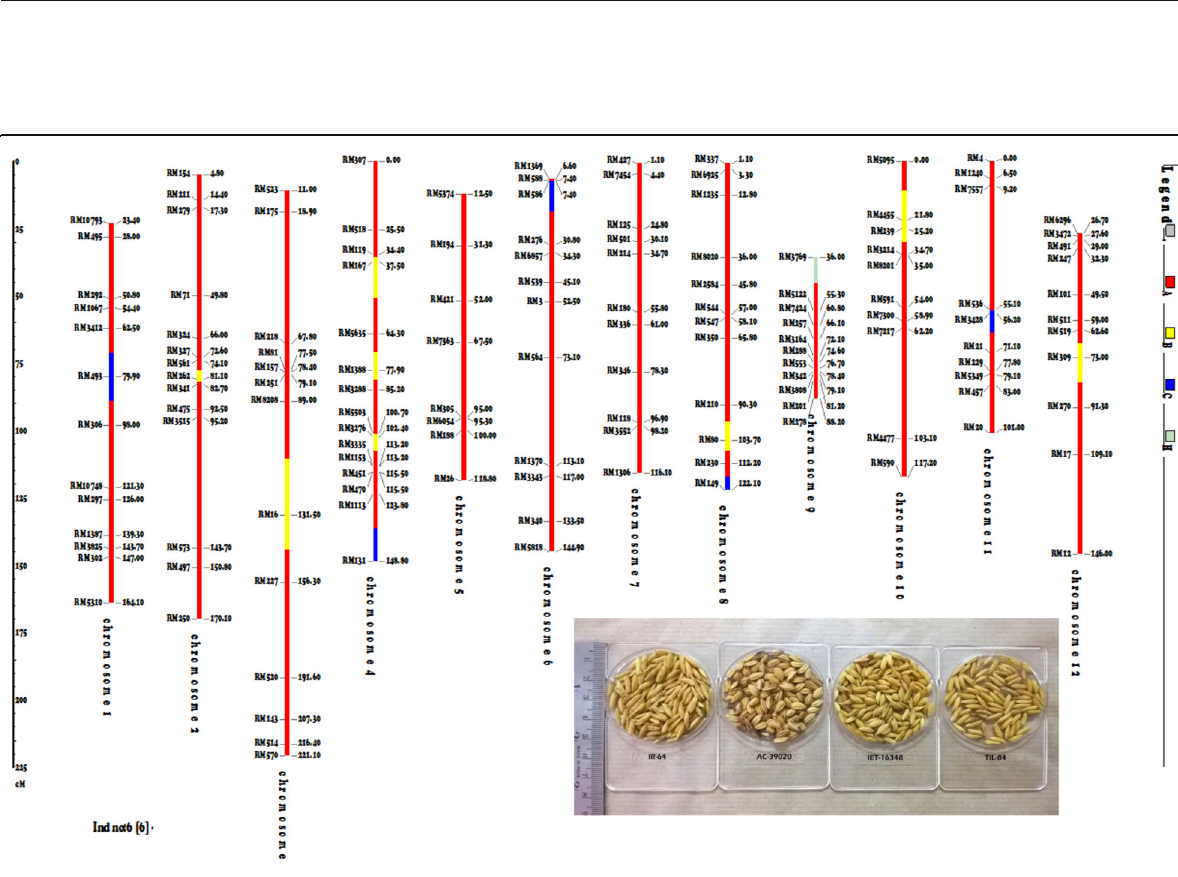
Fig. 4 Graphical genotyping plot and the grain characters (inset) for a selected TIL namely 32 – 1 – 40-78-84. Note: Red colour indicates homozygous region similar to IR-64 genome, Yellow colour indicate introgression of AC-39020 genome governing root QTLs and Blue colour indicates introgression of IET-16348 genome for WUE